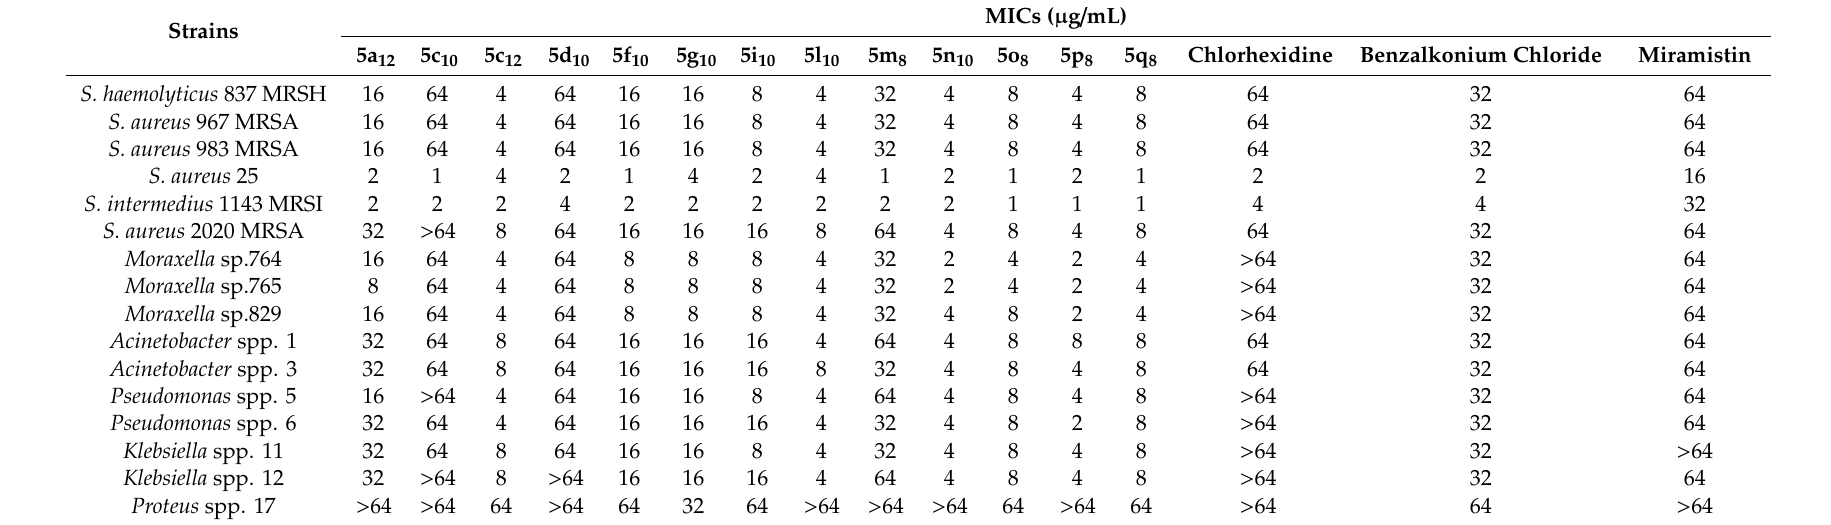
Table 2. In vitro antimicrobial activity of novel bis-ammonium salts of pyridoxine on clinical bacterial